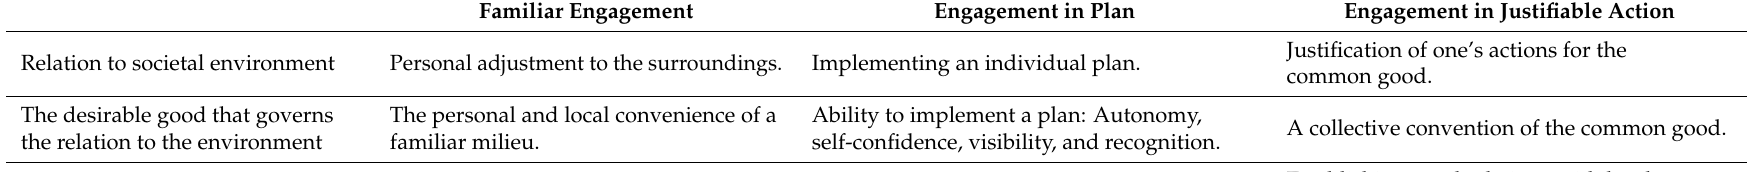
Table 1. Partly adapted from Th é venot 2001 and 2013. Cf also Th é venot